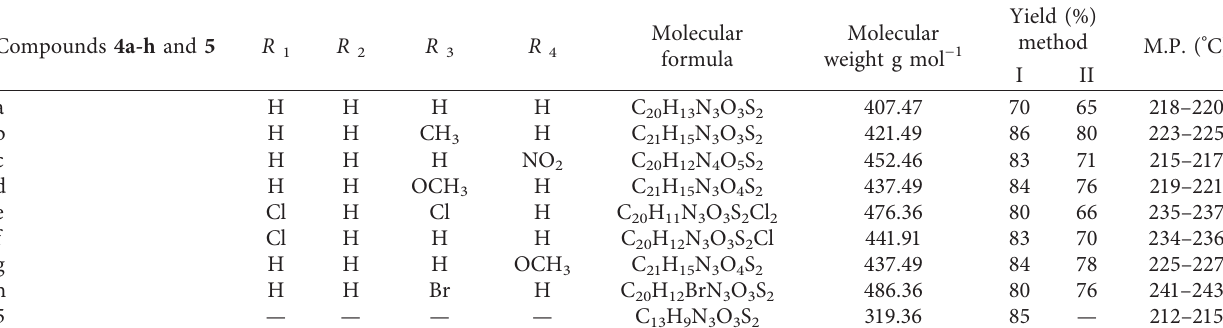
Table 1: Physical data of compounds ( 4a-h and 5